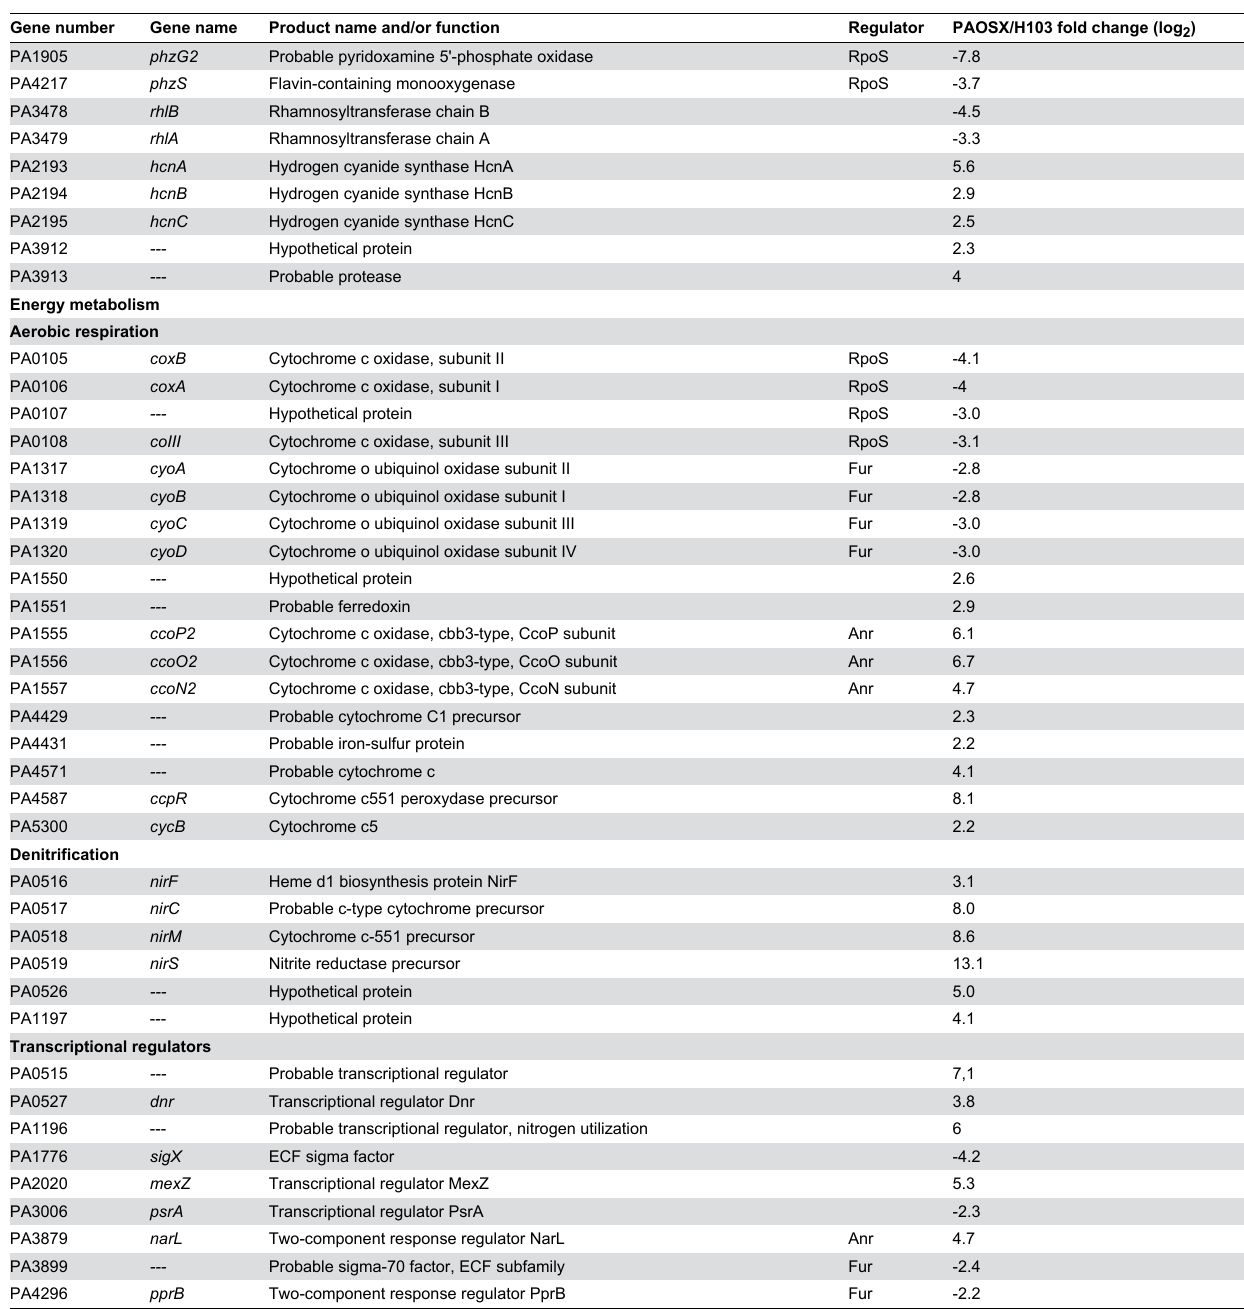
Only significantly ( p -value<0.05) dysregulated genes are included, and the log 2 fold change cut-off between PAOSX and H103 strains is 2, except for some genes which